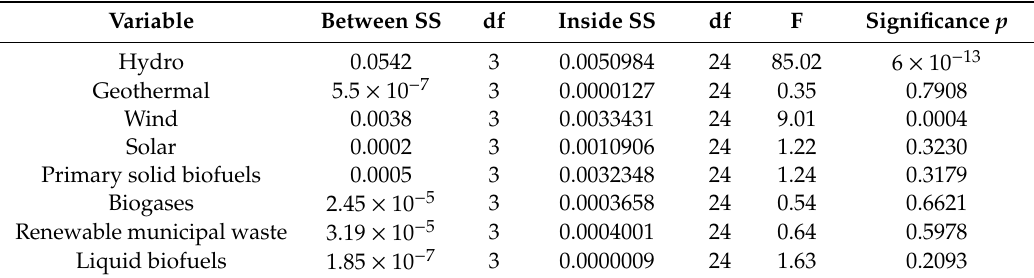
Table 17. Analysis of variance for renewable energy production (own